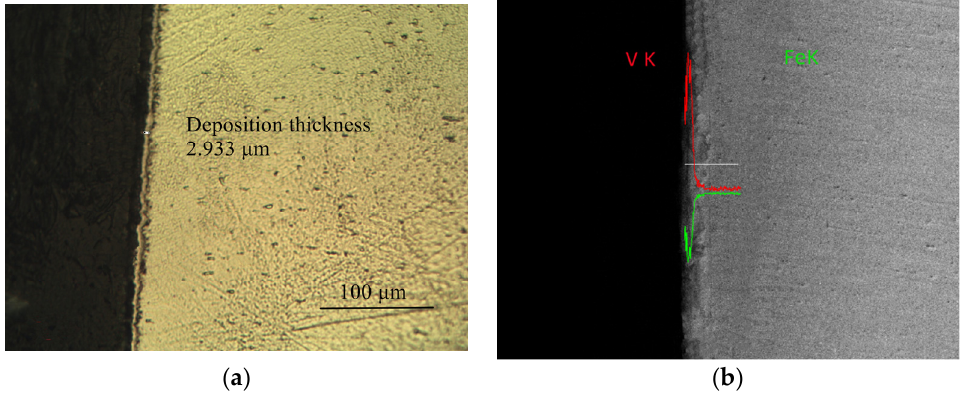
Figure 15. Appearance and EDS of section: ( a )appearance ( b ) EDS.